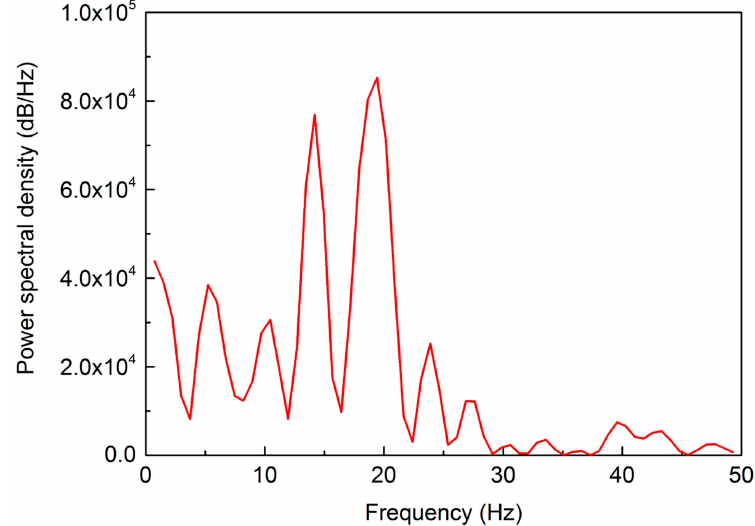
Figure 2. LSP spectral analysis results for the SNR sequences for GPS PRN 19 on February 28, 2018. A peak corresponds to a main frequency, but two similar peaks mean the failure of LSP in obtaining the main frequency.